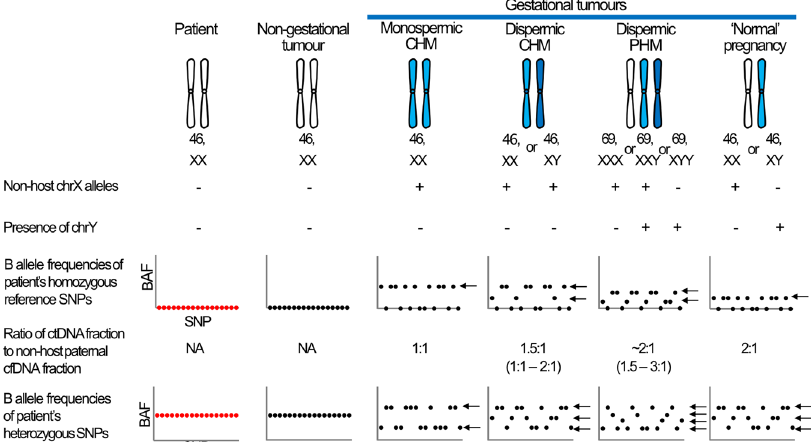
Fig. 1 Expected cfDNA pro fi les from tumours of different origins. Gestational tumours have chromosomes from the father of the pregnancy (blue). Monospermic complete hydatidiform moles are androgenetic, diploid and homozygous, due to absence of maternal DNA and duplication of a haploid sperm ’ s genome. Dispermic complete hydatidiform moles are diploid androgenetic, having two chromosome complements of paternal origin. Dispermic partial hydatidiform moles are triploid diandric, have two paternal chromosome complements and one maternal complement. Normal pregnancies are diploid, having one paternal and one maternal complement. The B allele frequencies (BAFs) (y axis) of each SNP (x axis) in cfDNA (black) from non-gestational tumours matches that of the patient ’ s gDNA (red), although the heterozygous SNPs may deviate from 50:50 due to copy number alterations (not shown). Due to differences in their genetic composition, cfDNA from gestational tumours display non-host alleles at different fractions and have different pro fi les for a patient ’ s homozygous and heterozygous SNPs, the latter of which may only be discernible at relatively high fractions of ctDNA. Thus, the non-host (paternal) cfDNA fraction may underestimate the ctDNA fraction. The presence of chrY and non-host chrX alleles is indicative of an XY or XXY dispermic molar pregnancy.